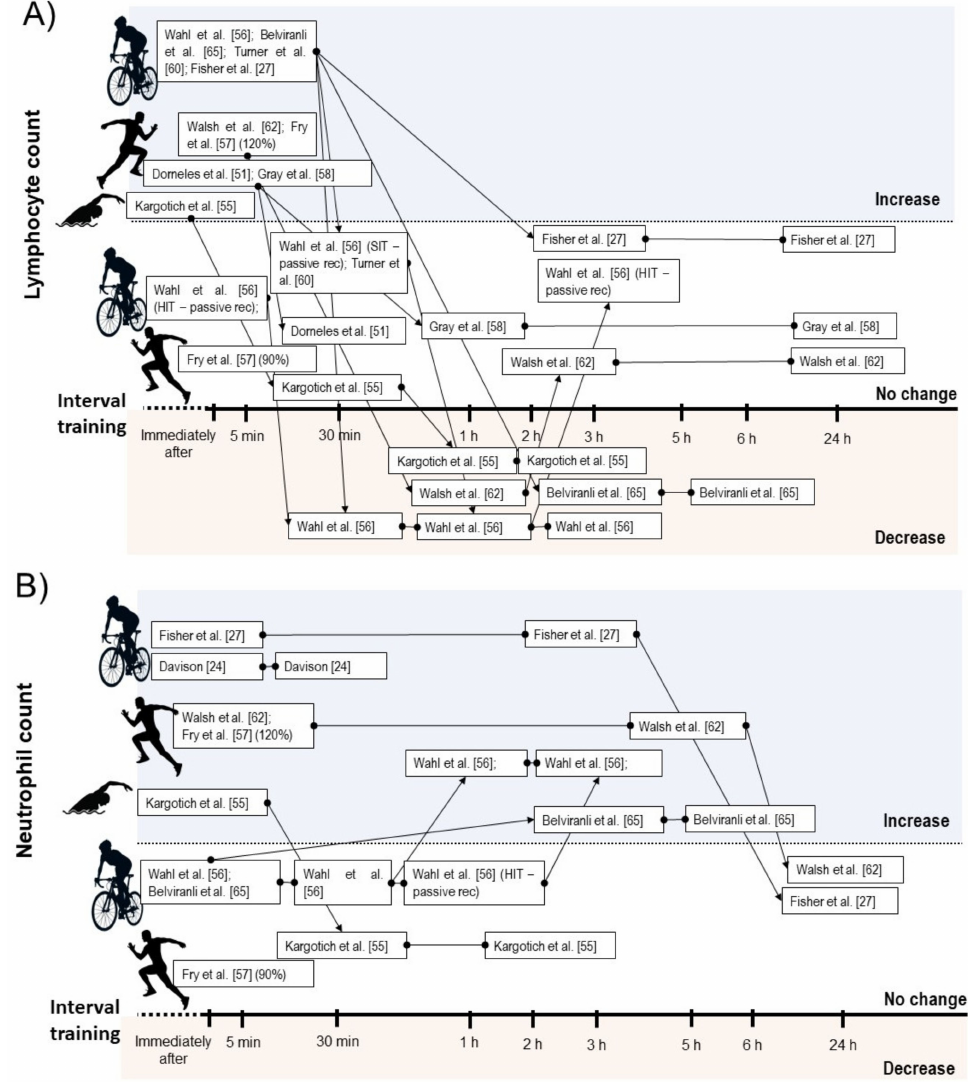
Figure 3. Illustration of time course of lymphocyte ( A ), and neutrophil count ( B ) after acute interval training